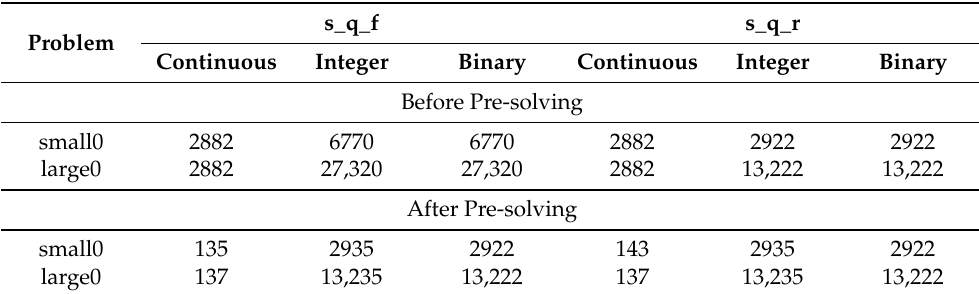
Table 4. Number of variables of different types in the first sub-problem, with the settings s_q_f and s_q_r before and after pre-solving for two problem instances.